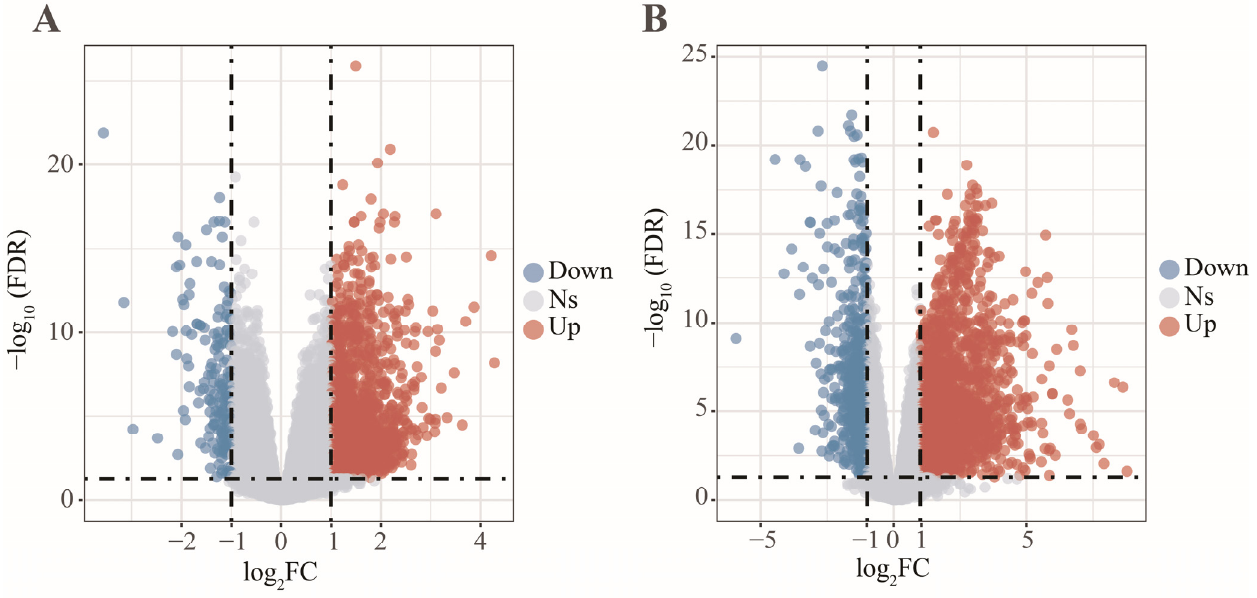
Figure 4. The differentially expressed analysis between COVID-19 patients and healthy controls. ( A ) The volcano plot of differentially expressed genes in GSE152641. ( B ) The volcano plot of differentially expressed genes in GSE171110.